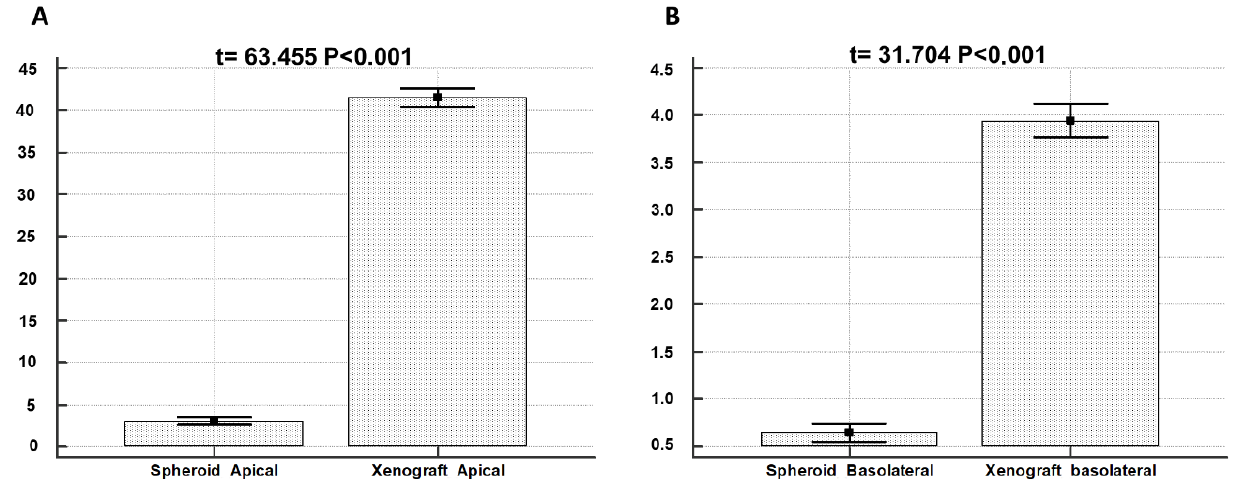
Figure 9. Comparison of MVBs secretion between spheroid and xenograft. ( A ) t -test results of sphe-